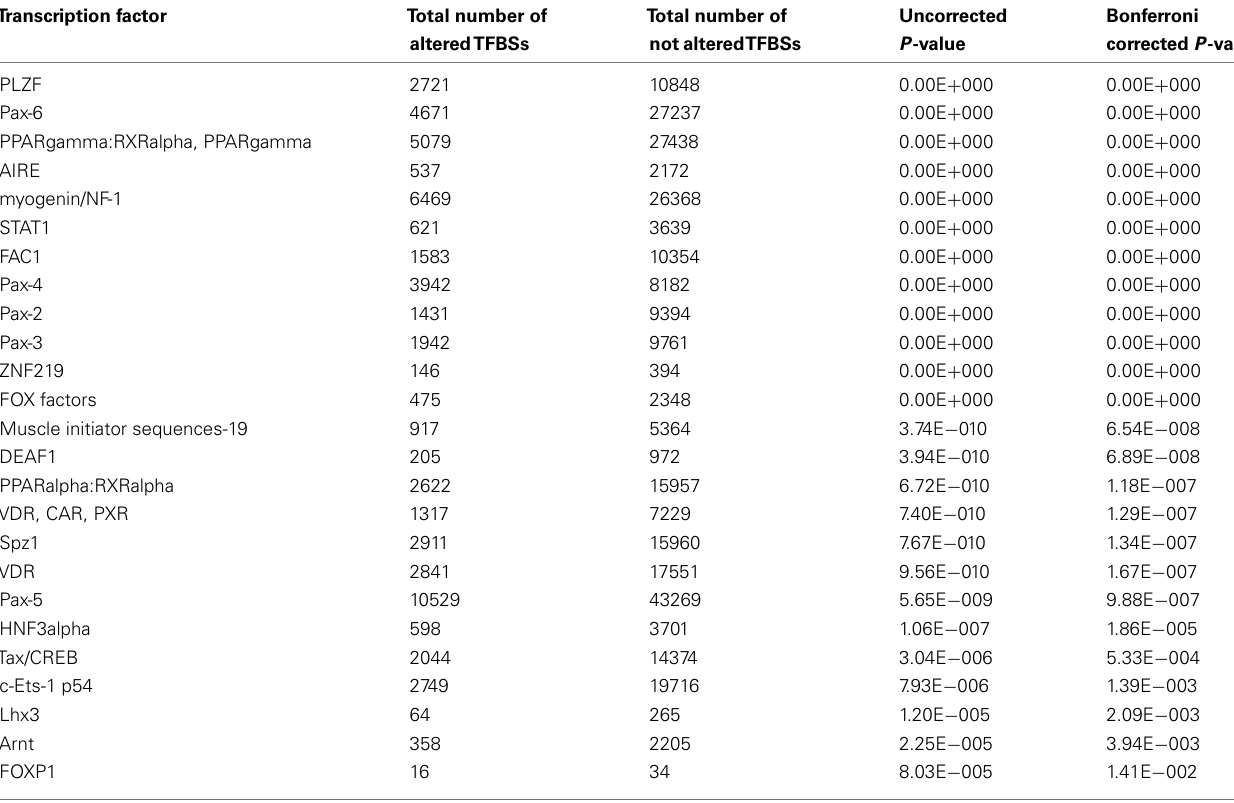
Table 2 | Statistically enriched